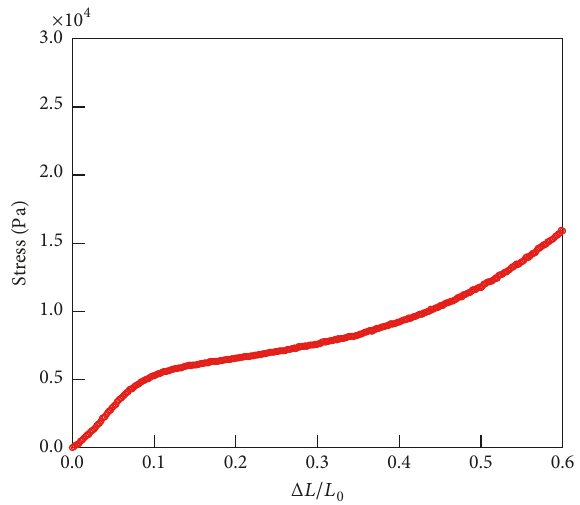
Figure 10: A stress-strain curve for 3 wt% 12-HSA/[ABIm][TFSI] gel prepared at a cooling rate of 0.4 ∘ C/min.